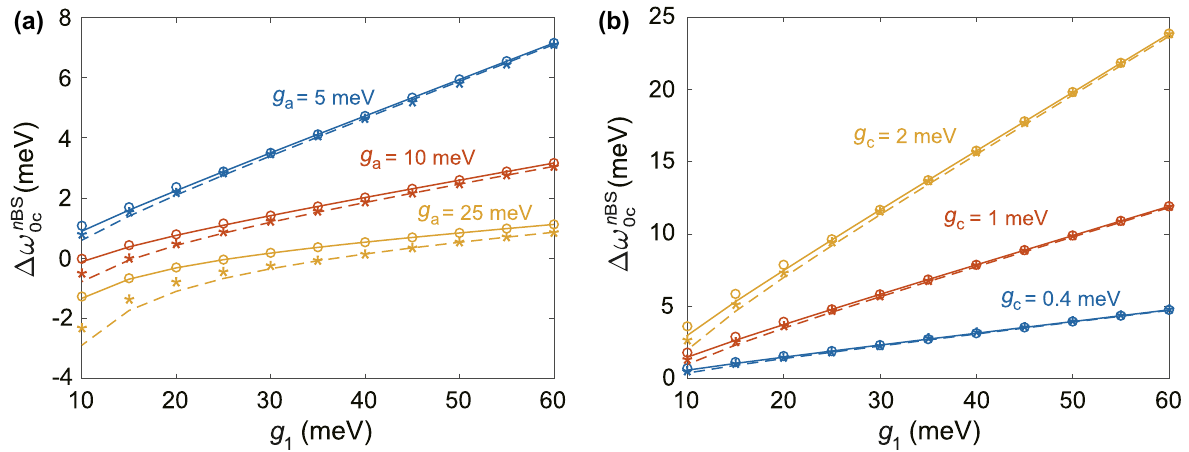
to predict the optimal conditions for quantum-optics applications. Comparison of Δ 𝜔 BS Figure 4: Applicability of analytical condition Δ 𝜔 n BS 0c (solid lines) and the optimal QE-cavity detuning Δ 𝜔 corresponding to the single-photon blockade with highest efficiency (hollow circles), 0c (dashed lines) and the optimal Δ 𝜔 for maximum concurrence in the longtime limit (stars) for different cases of (a) as well as Δ 𝜔 2 BS 0c 0c and (b) QE-photon coupling rate g , as a function of plasmon-photon coupling rate g QE-plasmon coupling rate g a c kept the same as those in Figure 3 unless mentioned